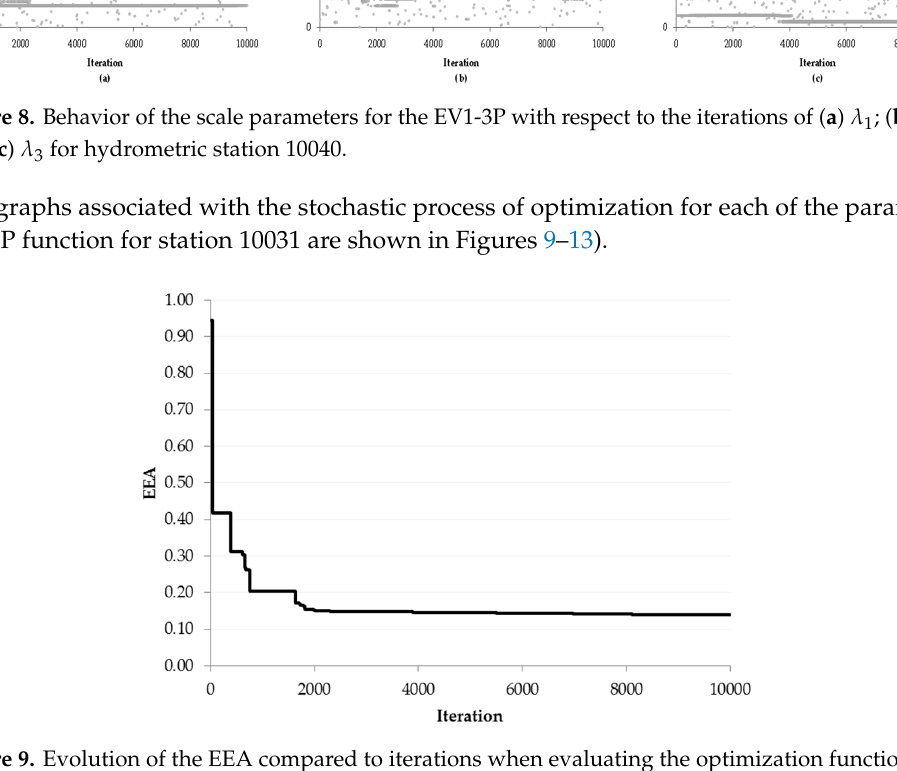
Figure 9. Evolution of the EEA compared to iterations when evaluating the optimization function for the EV1-3P of hydrometric station 10031.